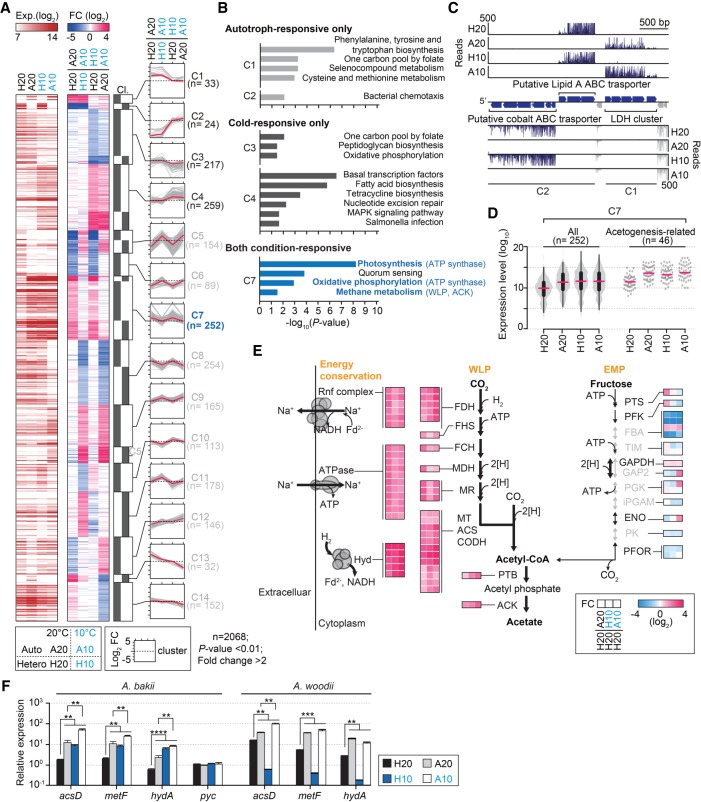

Transcriptome perturbations induced by the autotrophic and cold condition. (A) The autotroph-responsive only (C1 and C2), temperature-responsive only (C3 and C4), combined condition-responsive (C6, C7, C8, and C9), and particular condition-specific (C5, C10, C11, C12, C13, and C14) differential gene expression patterns were all combined and are shown as a heat map. The heat map shows log2 expression values (“Exp.”) and log2 fold-changes (“FC”) at 20°C heterotrophic (“H20”), 20°C autotrophic (“A20”), 10°C heterotrophic (“H10”), and 10°C autotrophic (“A10”) conditions. Black bars represent clustered columns resulting from K-mean clustering. Two thousand sixty-eight DEG are listed in Supplemental Table S4. C1 and C2 were highly up-regulated or down-regulated under autotrophic conditions, respectively; C3 and C4 were highly down-regulated or up-regulated at low temperature, respectively; C5 showed down-regulation of gene expression under A20, but their gene expression was inversely altered by cold temperature; the expression of C6 was down-regulated either by autotrophic or cold temperature conditions; the expression of C7 was up-regulated both by the autotrophic and cold temperature conditions; C8 and C9 were found to be highly down-regulated and up-regulated by A10, respectively; C10 and C11 were found to be highly up-regulated and down-regulated by H10, respectively; C12 and C13–C14 were found to be highly down-regulated or up-regulated by A20, respectively. Clustering was performed based on gene expression-fold change. Twenty-one clusters were assigned to 14 clusters manually. Gray and red lines indicate log2 (fold-changes) and median of each group, respectively. See also Supplemental Table S4 for all transcript abundances. (B) Enriched KEGG pathways of the C1, C2, C3, C4, and C7 clusters. Bonferroni-corrected P < 0.05 was considered as the significance cutoff. KEGG pathways, including acetogenesis-related genes, are highlighted in bold blue. For clarity of illustration, KEGG enrichment significance is shown as −log10 (P-value). See also Supplemental Figure S2. (C) An example of RNA-seq profiles for the genes in the A group. RNA-seq reads of both strands are shown. The putative cobalt ABC transporter cluster (ABAKI_c2420–c24260), a putative lipid A ABC transporter (ABAKI_c24270–c24290), and the bifurcating lactate dehydrogenase gene cluster (ABAKI_c24310–c24350) are highlighted in indigo blue. (D) A violin plot shows the expression distribution for the genes in the C7 group. See also Supplemental Figure S3. (E) DEG involved in acetogenesis, as well as in the glycolysis and gluconeogenesis pathways. Low temperature triggers the expression of acetogenesis-related genes. Bold and gray arrows indicate positive and negative regulation, respectively, under the cold-heterotrophic growth condition (H10). The heat map shows log2 fold-changes. See also Supplemental Table S5. (F) Quantitative RT-PCR data of acsD (from the carbonyl branch of the WLP), metF (from the methyl branch of the WLP), hydA (from the FDH operon), and pyc genes. The graph shows fold-changes in the transcript abundance of A. bakii and A. woodii for the four different growth conditions. Each value is the mean of three replicates in independently repeated experiments, and error bars show ±SEM. The secA gene was used as the reference. (**) P ≤ 0.01 > 0.001; (***) P < 0.001 (Student's unpaired t-test).